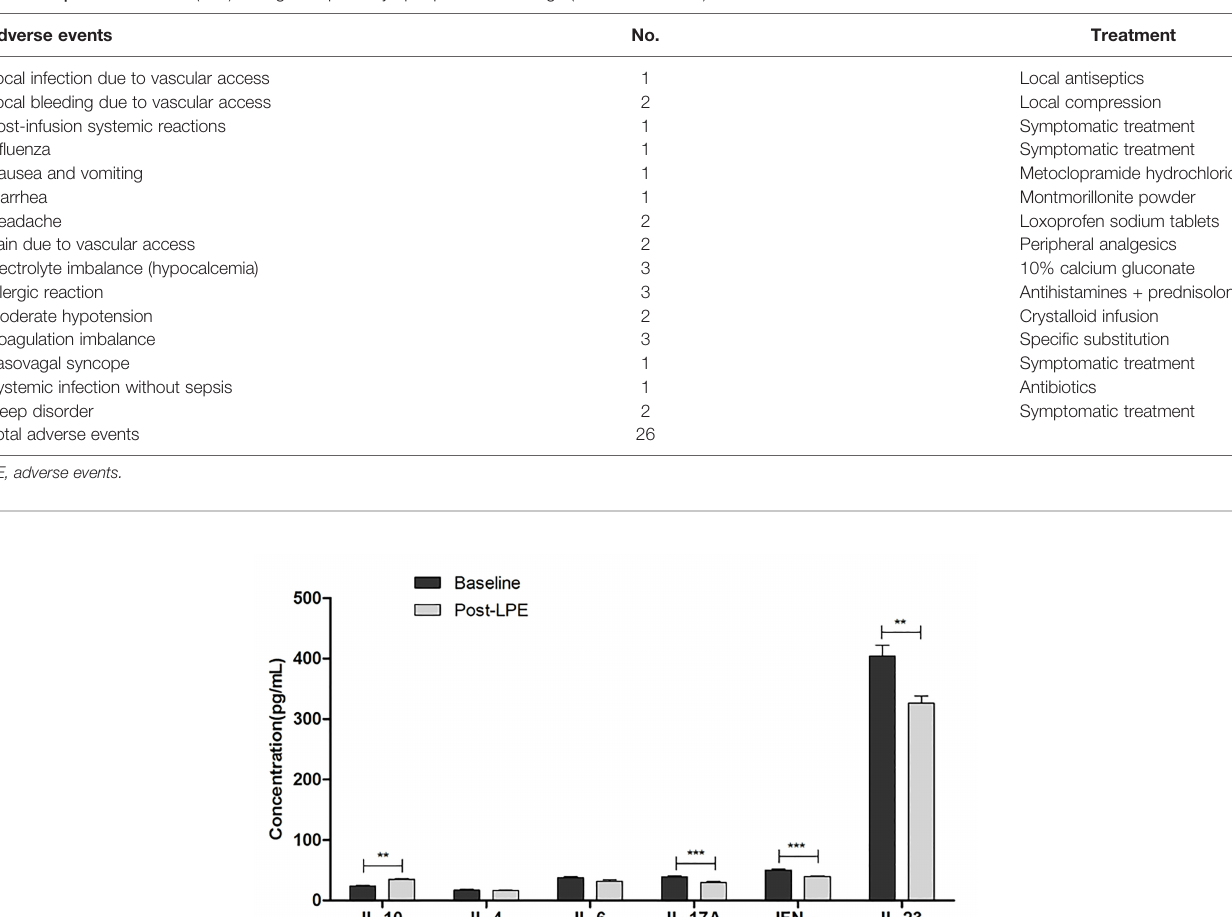
TABLE 3 | Adverse events (AEs) during therapeutic lymphoplasma exchange (n = 635 sessions). Adverse events No.